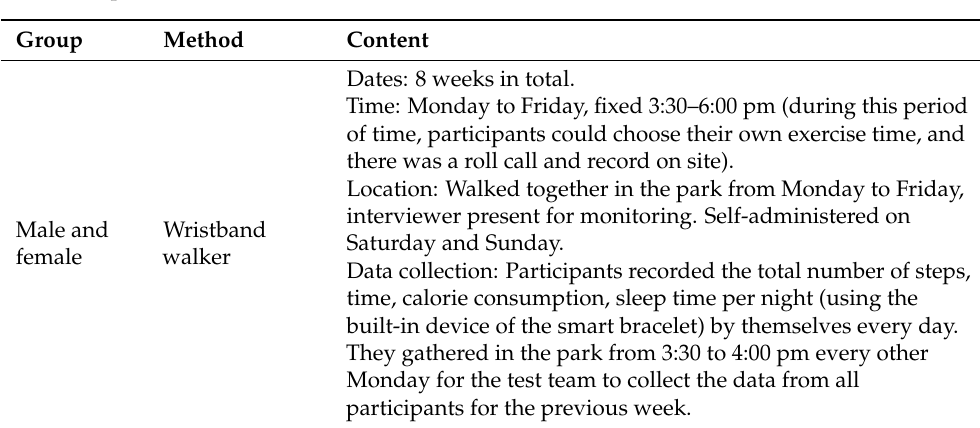
Figure 1. Participants and study flow diagram. Table 1. Experimental method and